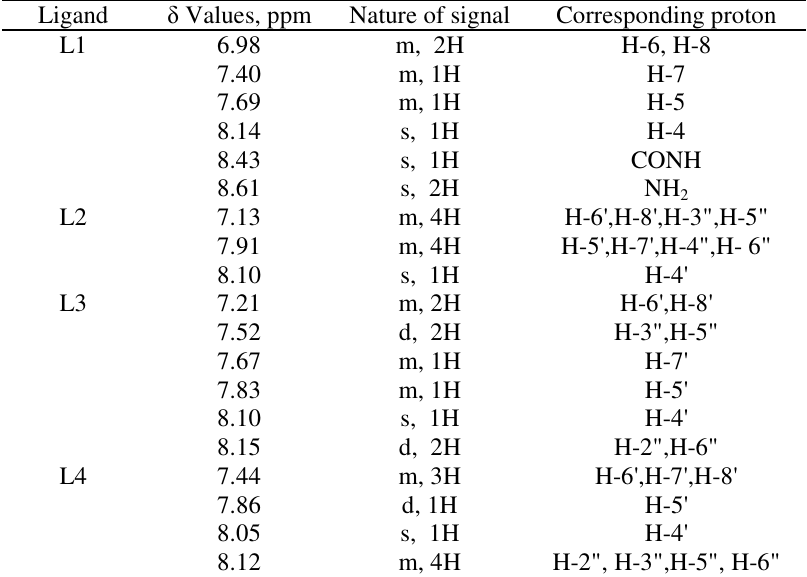
Table 2. The 1 H NMR spectral data of the